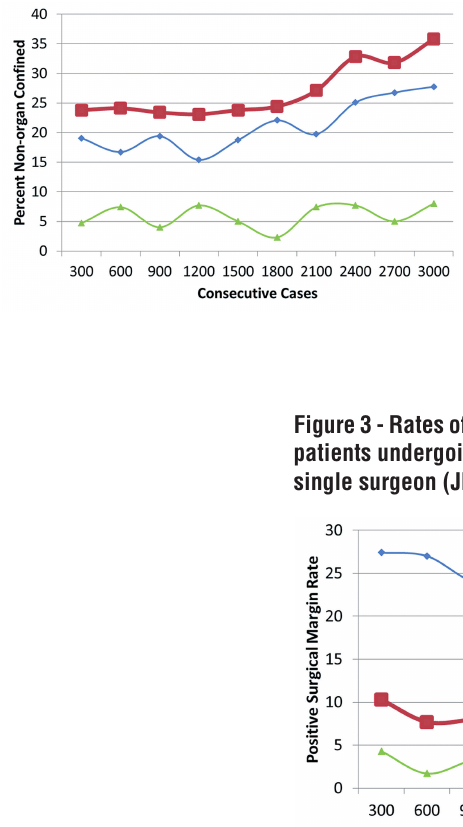
figure 1 - percent of non-organ confined prostate cancer in 3000 consecutive patients undergoing open radical retropubic prostatectomy by a single surgeon (JBn).